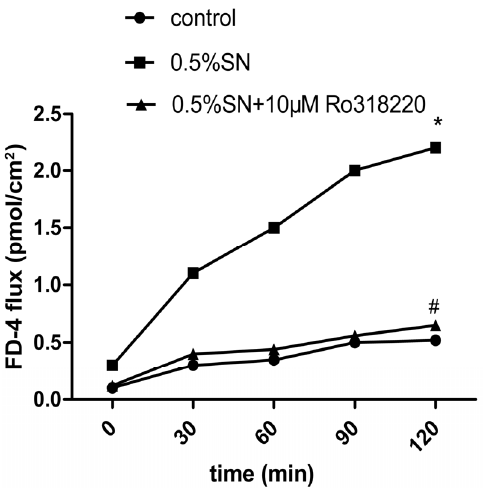
Figure 4. Effects of SN on FD-4 flux in Caco-2 cell monolayers (A-B). Control group means 0.1% FD-4 alone, SN group means 0.5% SN + 0.1% FD-4, SN + Ro318220 group